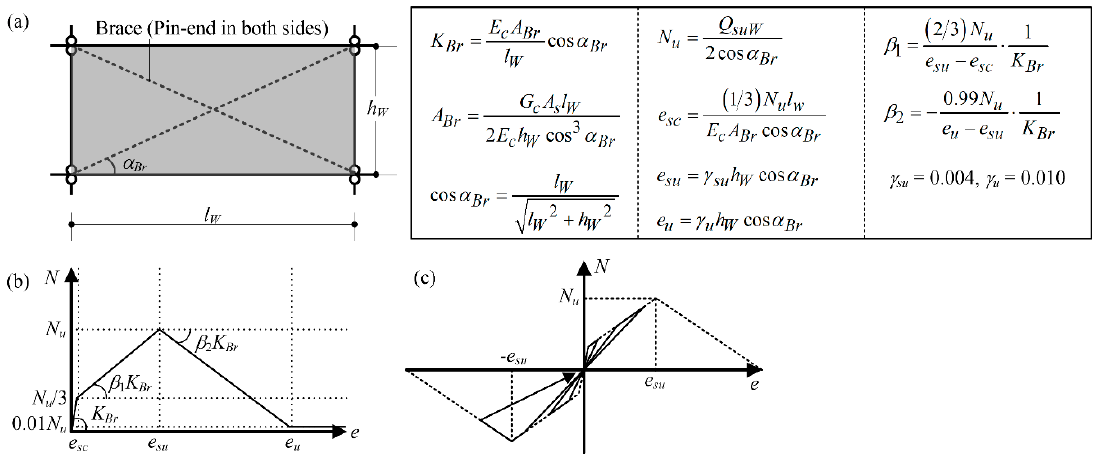
Figure 11. Simplified model of the concrete wall: ( a ) model, ( b ) envelope of the force-deformation relationship of the nonlinear brace (concrete wall), and ( c ) hysteresis rule.